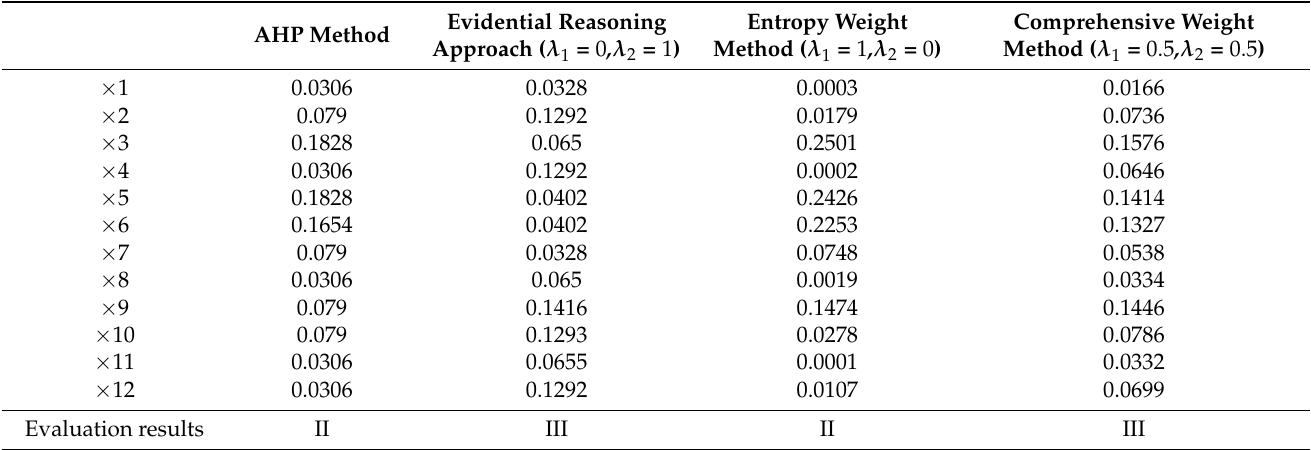
Table 5. Comparison of weight